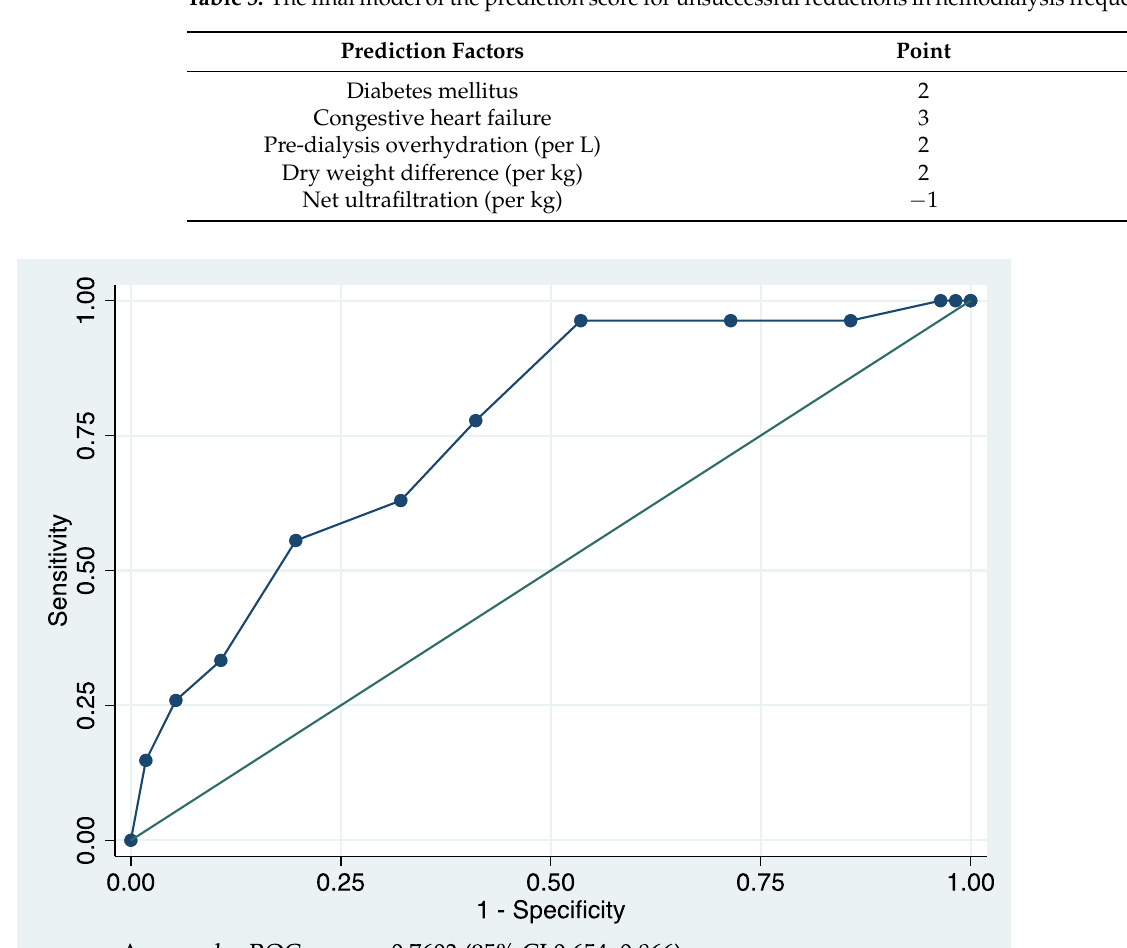
Figure 2. The receiver operating characteristic (ROC) curves and the area under the ROC (AUROC) of the final prediction model for unsuccessful reductions in hemodialysis frequency.